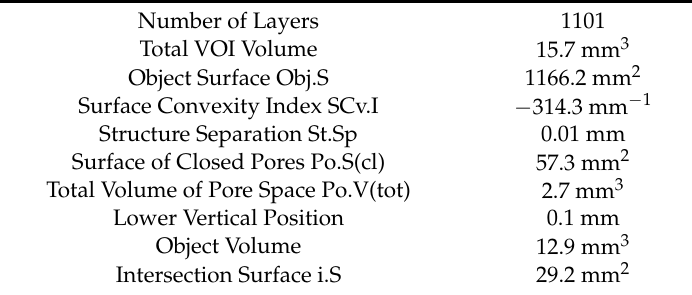
Table 1. Experimental observation of the magneto-rheological elastomer (MRE) sample with micro-computed tomography (µCT).